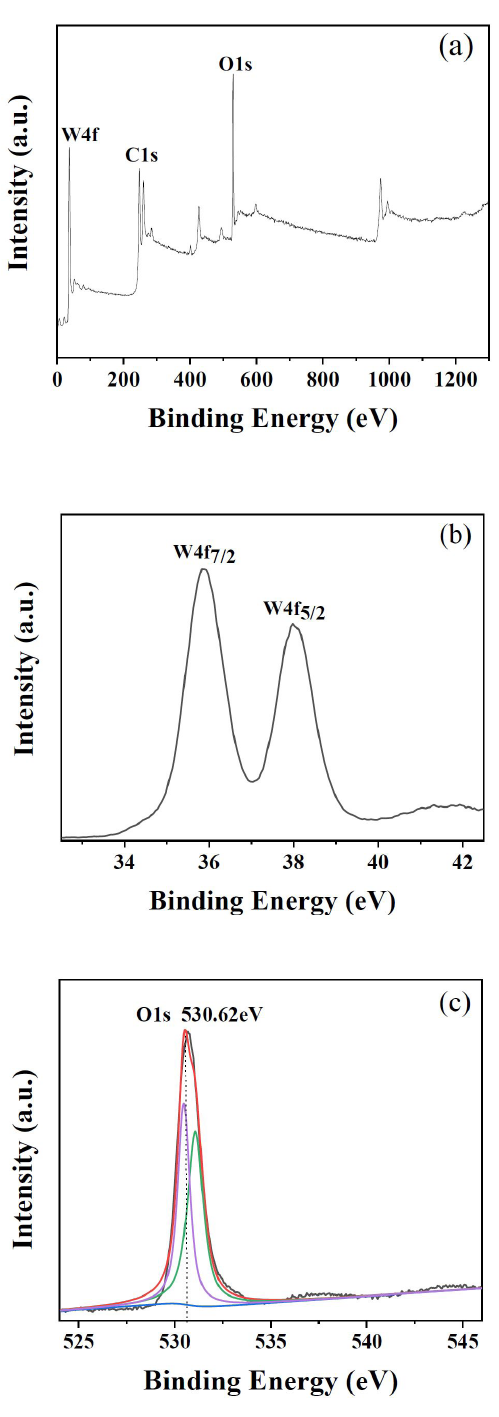
. (a) wide scan spectrum, (b) W4f 3